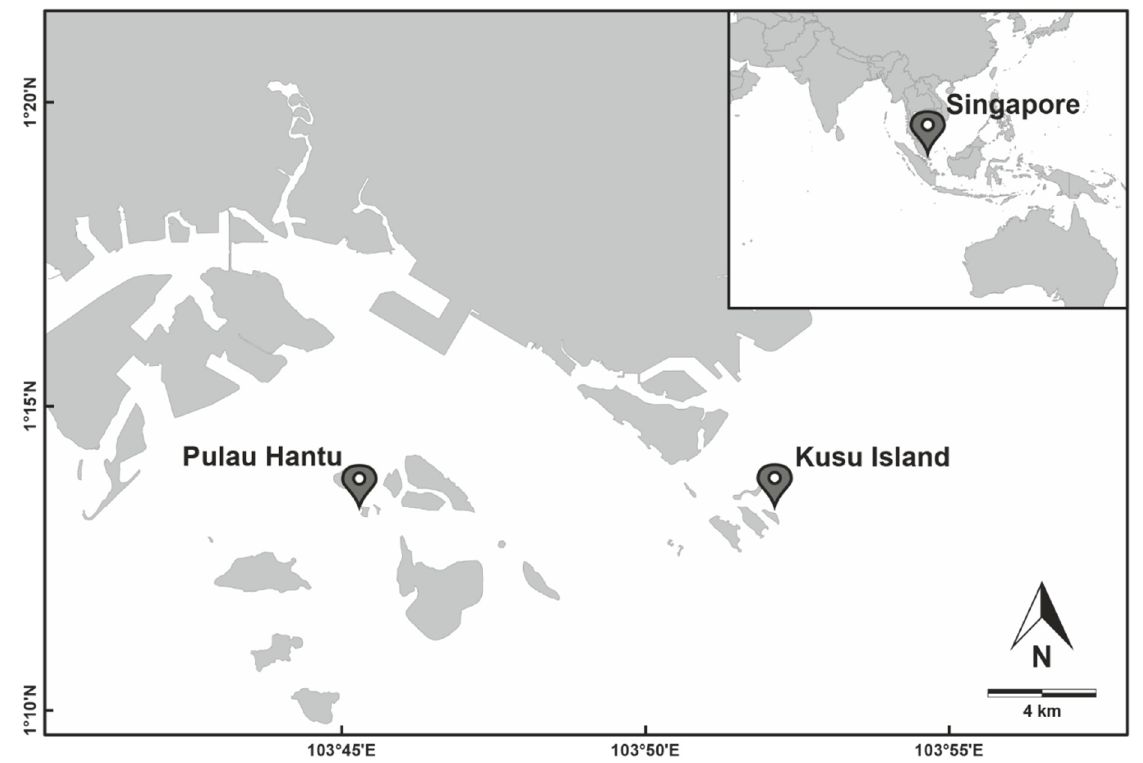
Figure 1. Map of the study area showing the two investigated sites. Pulau Hantu is a sheltered site situated 8 km south of mainland Singapore, while Kusu Island is located 6.4 km south of Singapore’s city center and 13.4 km east of Pulau Hantu.